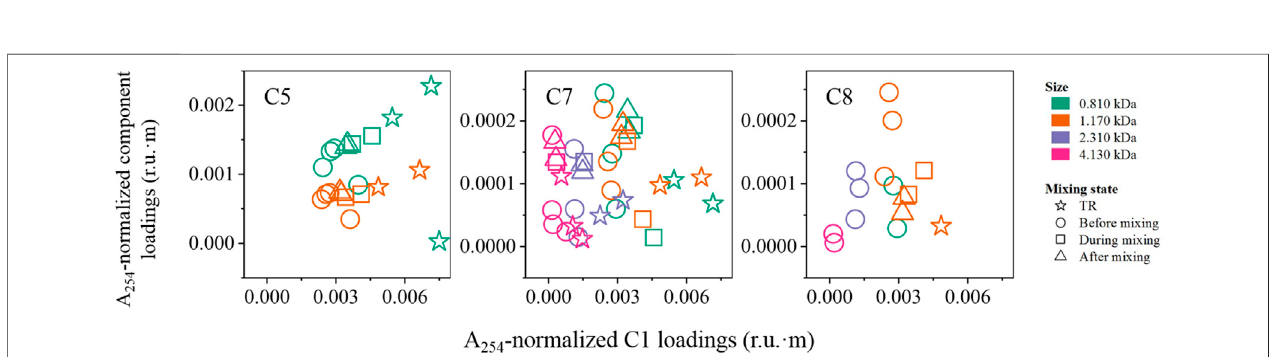
FIGURE9| Ratios ofA 254 -normalizedPARAFACcomponentloadings (r.u. · m) by C1forprotein-likecomponents (C5, C7,and C8)found inthis study. TRdenotes tributaries. Before, during, and after mixing refer to mixing states of the mainstem.